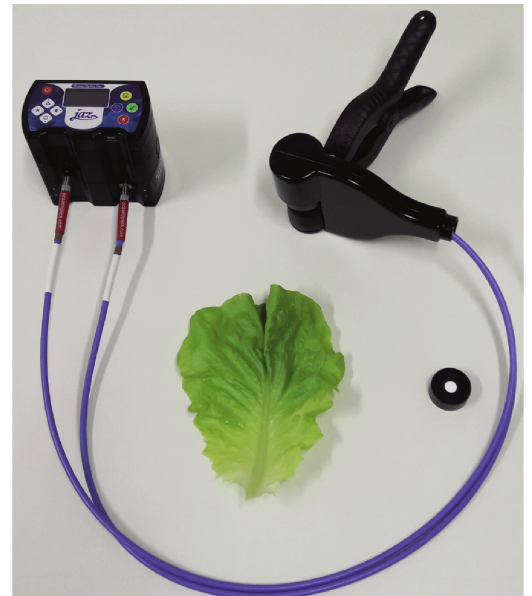
Fig. 1 ­ Hand­held spectrometer, clip probe, and diffuse reflec­ tance standard used to collect reflected light from the lettuce